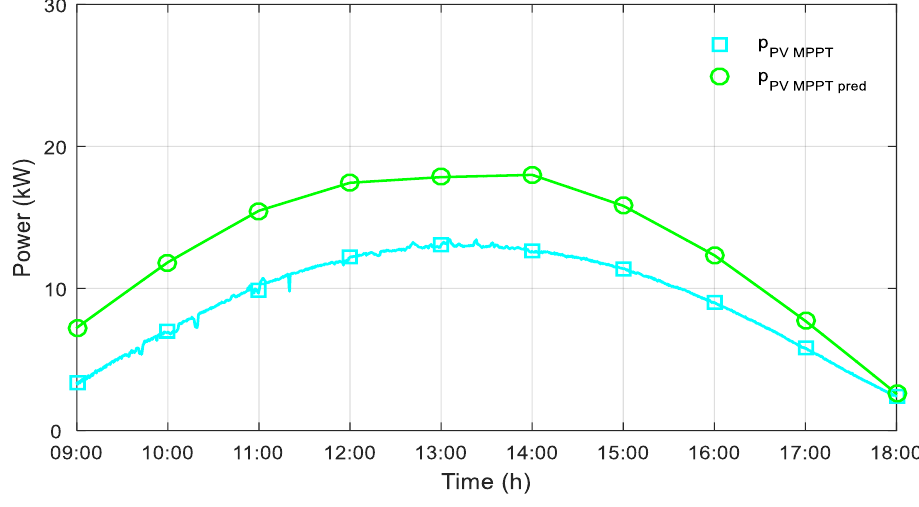
Figure 9. PV MPPT real and predicted powers — case 2.